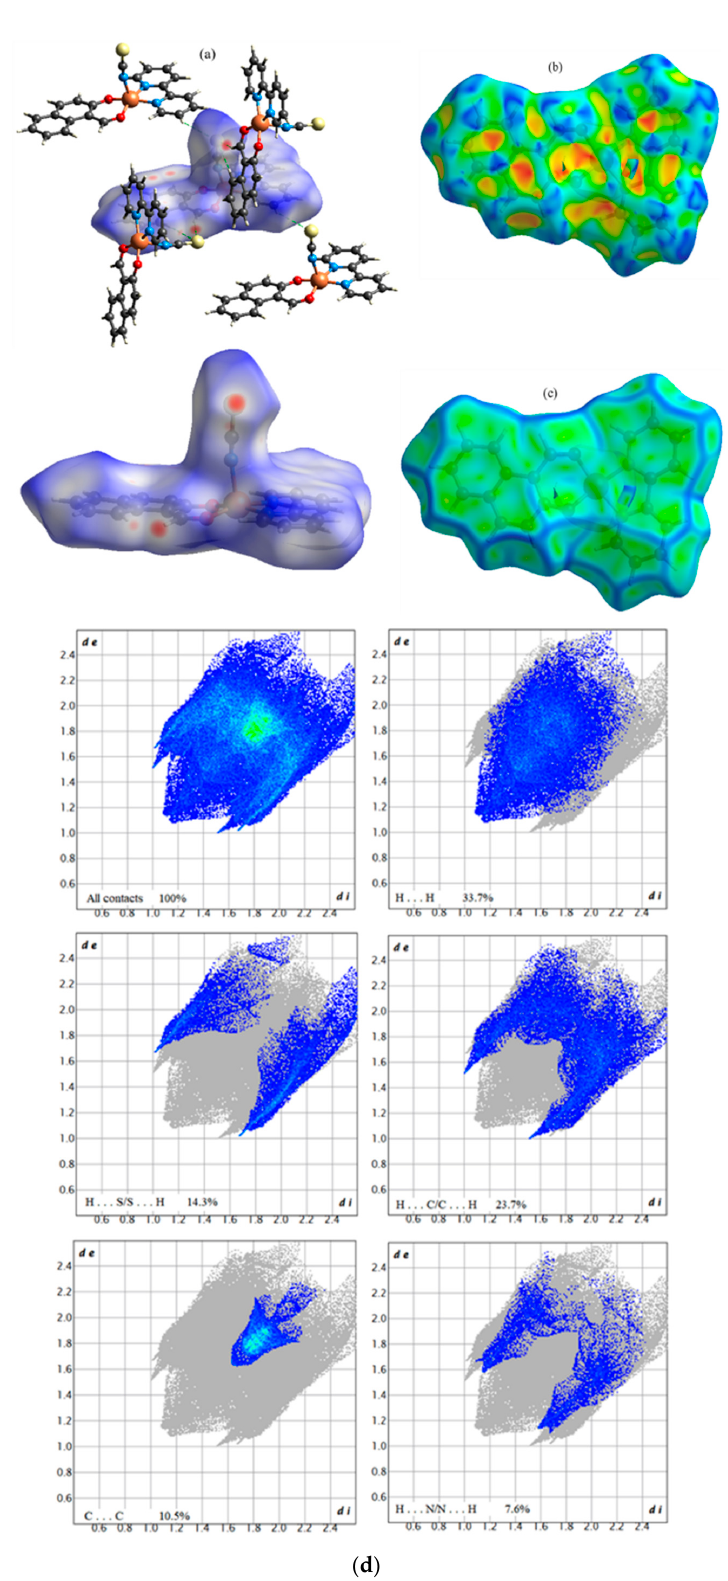
Figure 6. A view of the Hirshfeld surface for (I), which is mapped over ( a ) d norm in the range of − 0.1832 to +1.3833 arbitrary units. ( b ) Shape–index, ( c ) curvedness, and ( d ) 2-D fingerprint plots for the C-1 complex, which reveal the contributions of all